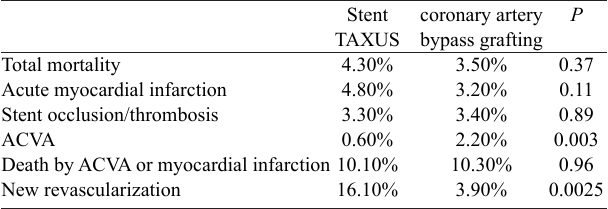
Table 2. Results on te follow-up year of the SYNTAX trial